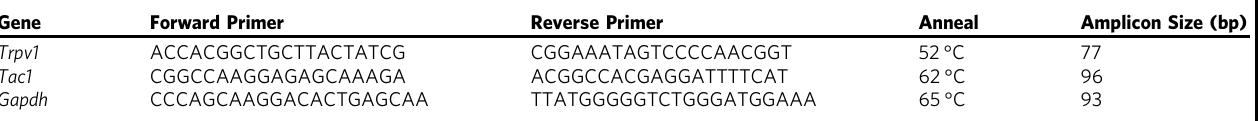
Table 1 Genetic speci fi c primers for single cell